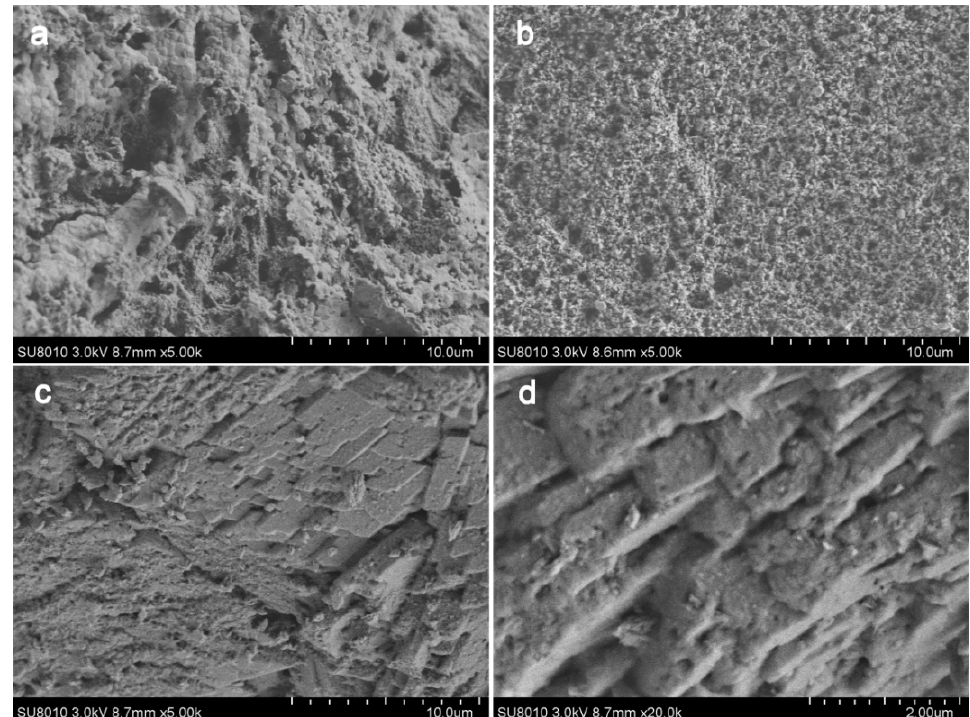
Figure 5. The micro-structure evolution of the bone samples. ( a ) Untreated, ( b ) treated by CSH, ( c , d ) treated by both CSH and water. ( c , d ) treated by both CSH and